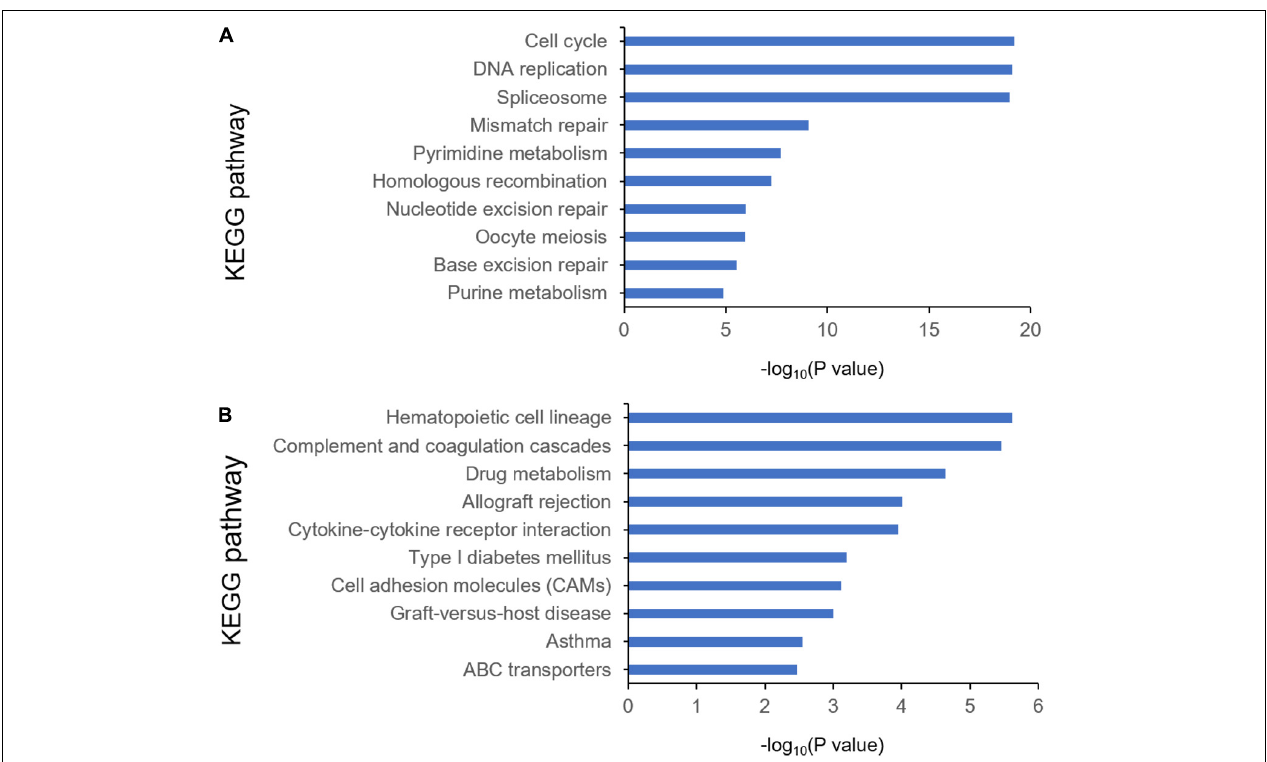
FIGURE 4 | KEGG pathway by analyzing overexpressed genes in each EAC subtype I (A) and subtype II (B) .